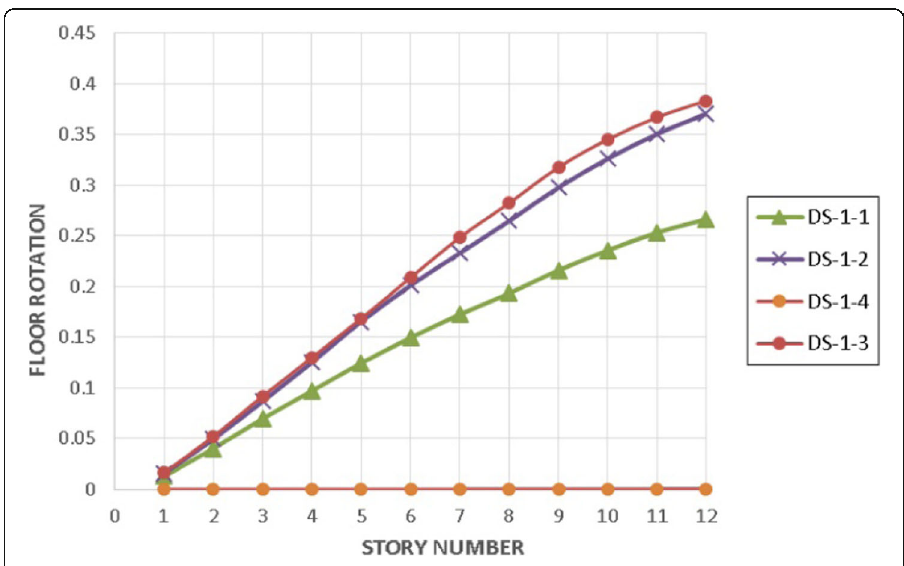
Fig. 32 Comparison of floor rotations — floor number for (DS-1-1, DS-1-2, DS-1-3, and